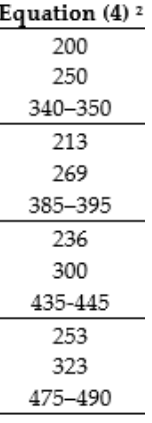
7. Figure 11 should be replaced by the following figure: